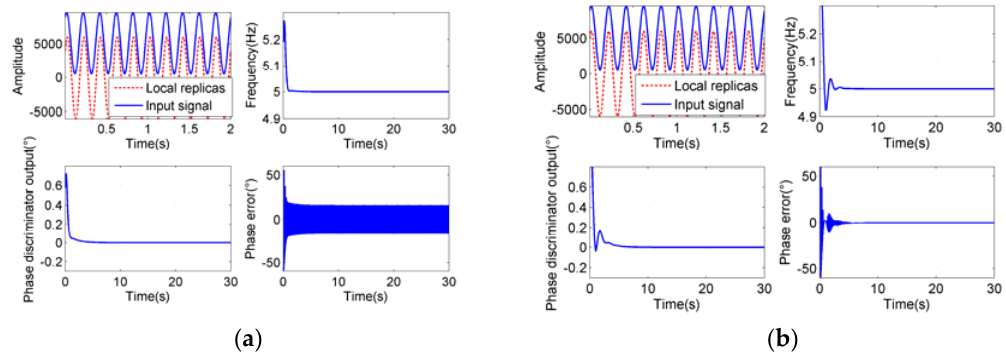
Figure 14. Tracking process at rotational speed of 5 Hz, B FLL = 0.3 Hz, B PLL = 0.3 Hz, ξ = 0.3. ( a ) is the tracking result at T roll = 100 ms, ( b ) is at T roll = 200 ms.